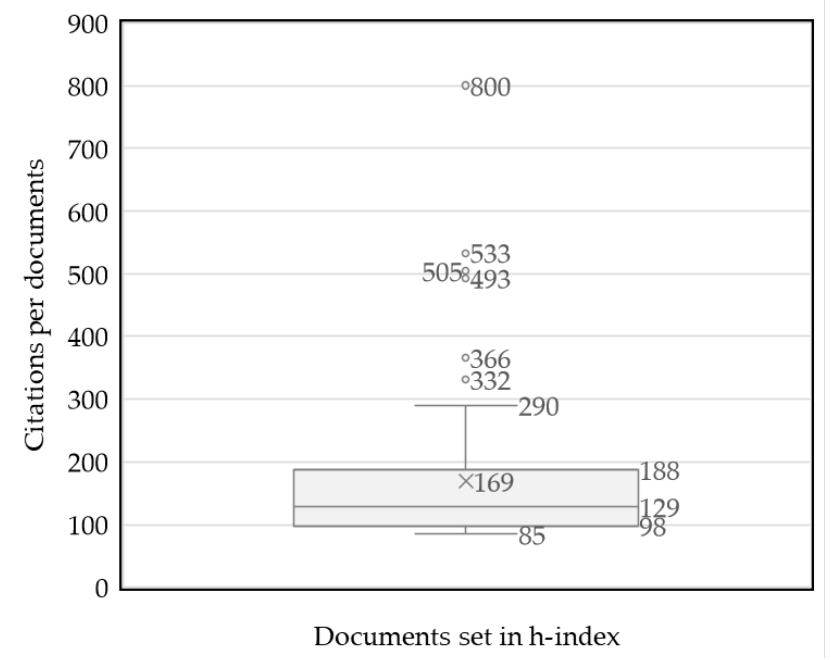
Figure 6. Citations per article on Fibromyalgia and Physical Activity.